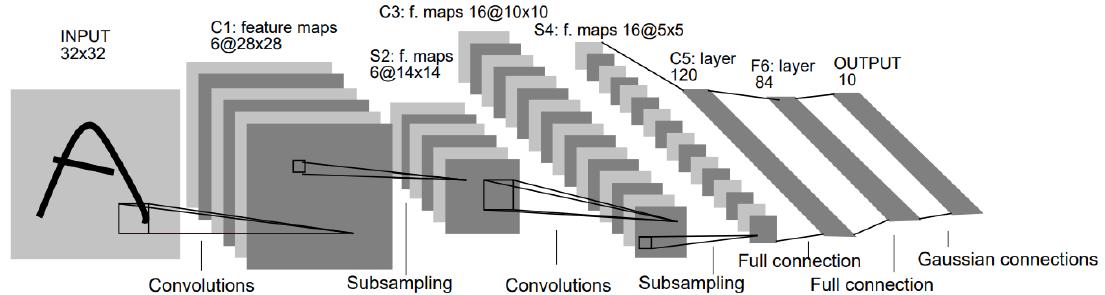
Figure 3. A classic convolutional neural network (CNN) model: LeNet-5 architecture (original image published by LeCun Y. et al. [6]). It consists of two sets of convolutional and average pooling layers, followed by a flattening convolutional layer, then two fully-connected layers and finally a softmax